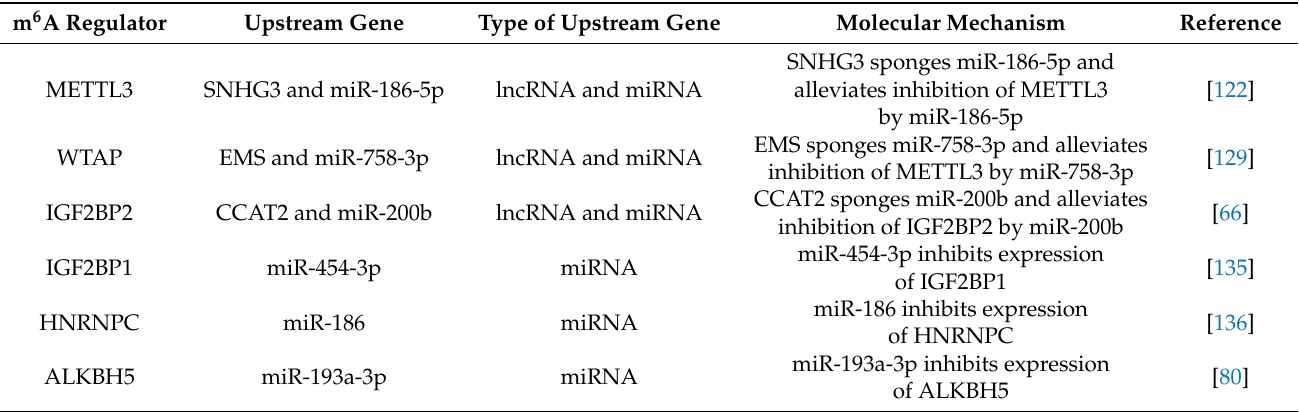
Table 2. The m 6 A regulators regulated by non-coding RNAs in ESCA. m 6 A